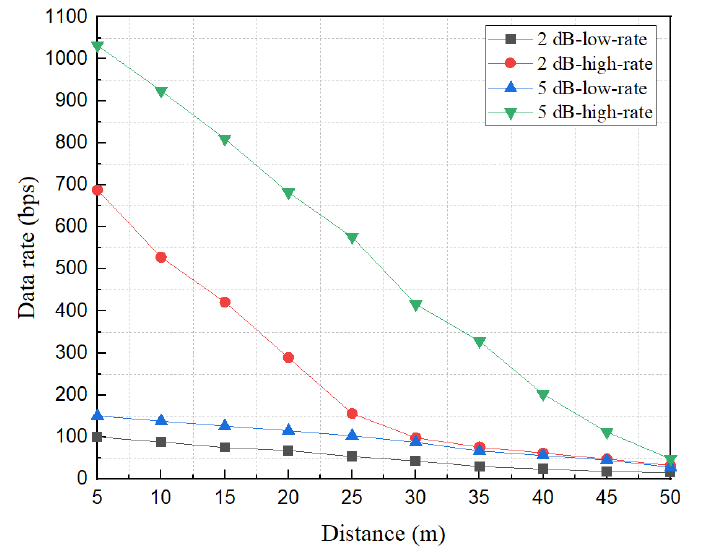
Figure 13. Variation of data-rate with distance at 2 dB and 5 dB transmitter power